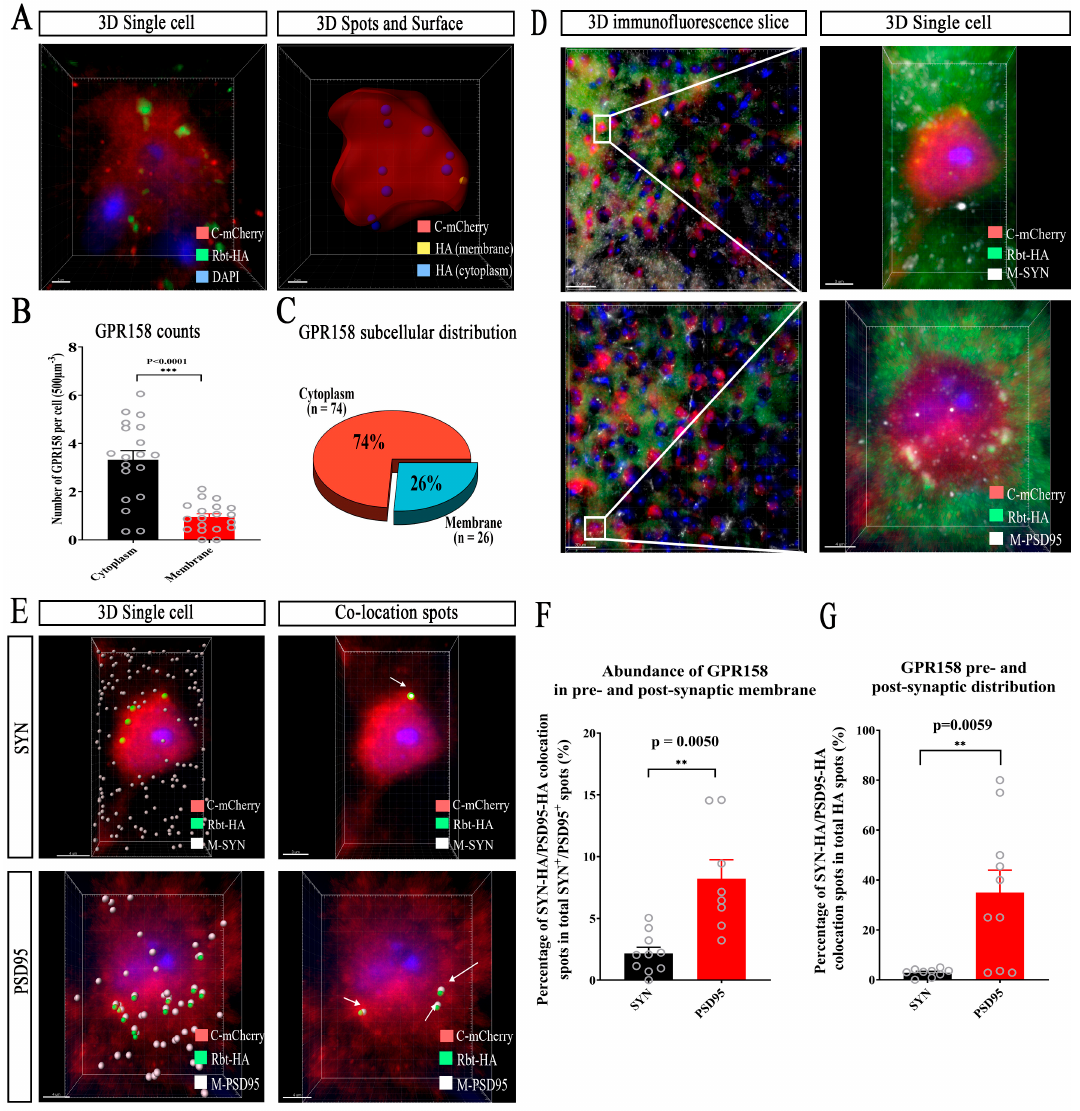
Figure 6. Analysis of subcellular localization of GPR158 in cortical layer 2/3 neurons in GPR158 Tag mice at P60. ( A ) 3D model of GPR158 and its distribution on the membrane and in the cytosol of individual neurons in layer 2/3 of the GPR158 Tag mouse cerebral cortex using HA-labeled GPR158 and tdTomato-labeled cell bodies. ( B ) Abundance of HA-labelled GPR158 on the membrane and in the cytosol of individual neurons in layer 2/3 of the cerebral cortex of GPR158 Tag mice (tdTomato + cells (n = 19) from GPR158 Tag mice (n = 4, male, P60), ***: p < 0.001). ( C ) Percentage of HA-labeled GPR158 distributed on the membrane and in the cytosol of individual neurons in layer 2/3 of the cerebral cortex of GPR158 Tag mice (tdTomato + cells (n = 19) from GPR158 Tag mice (n = 4, male, P60), ***: p < 0.001). ( D ) Immunofluorescence staining showing co-localization of HA-labeled GPR158 with SYN or PSD95 in the cerebral cortex of GPR158 Tag mice at single cell resolution. ( E – G ) 3D co-localization of HA-labeled GPR158 with SYN ( E ) or PSD95 ( E ) in individual cells in the cerebral cortex of GPR158 Tag mice, the percentage ( F ) of GPR158 binding to SYN or PSD95, and the pre- and postsynaptic distribution ( G ) of HA-labeled GPR158 (SYN + cells: n = 10; PSD95 + cells: n = 10; GPR158 Tag : n = 4, P60, male; **: p < 0.01). Data are mean ±